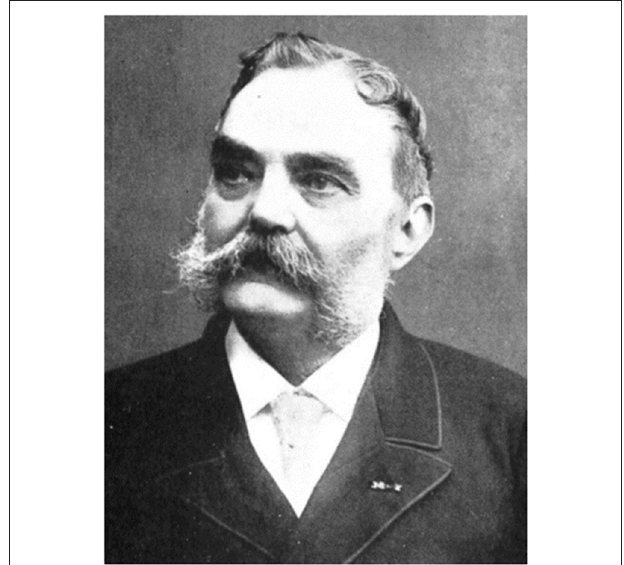
FIGURE 6 | Alexandre Liautard, father of the American veterinary profession. Alexandre François Augustin Liautard (1835–1918), after obtaining his veterinary diploma from the National Veterinary School of Toulouse in 1856, emigrated to the United States in 1859. He moved to New York to practice the profession of veterinarian. At that time, there was no University in the USA to train veterinarians but Liautard founded a private college in New York (the New York American Veterinary College). Further, he assisted in the organization of the American veterinary profession and founded the United States Veterinary Medical Association, today the American Veterinary Medical Association. He was also the founder of the American Veterinary Review, now the Journal of the American Veterinary Medical Association (JAVMA). Liautard popularized in the USA the ideas of Pasteur, encouraging American veterinary medicine, then dominated by hippiatry, to adopt scientific approaches in the field of infectious diseases. As in Europe, this led to re-structuring based on science (see the Wikipedia article)